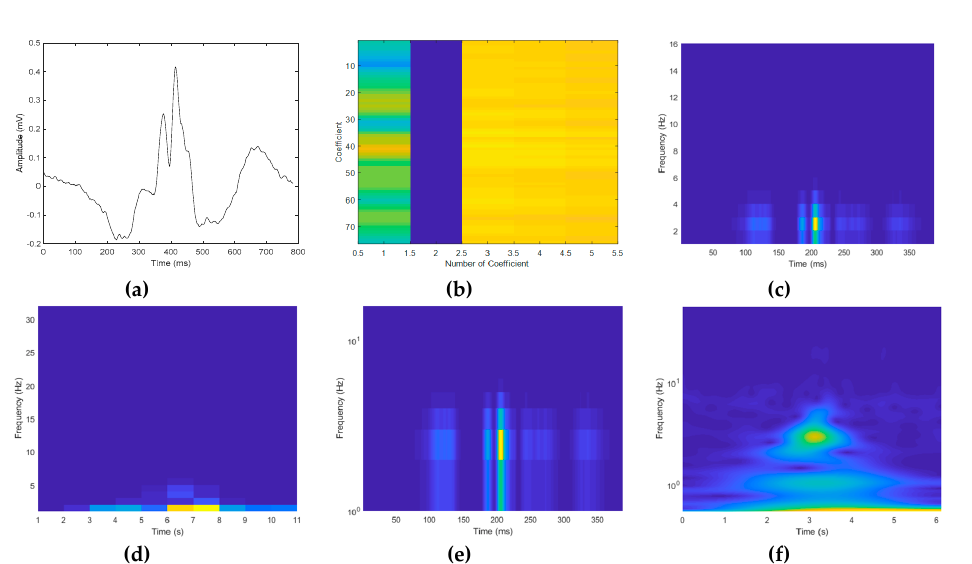
Figure 7. Time-frequency representation: ( a ) original signal; ( b ) MFCC; ( c ) spectrogram; ( d ) mel spectrogram; ( e ) log spectrogram; ( f ) scalogram.